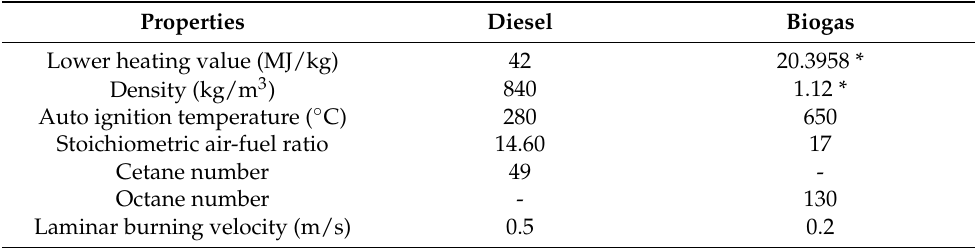
Table 2. Fuel properties, Bouguessa et al. [20].